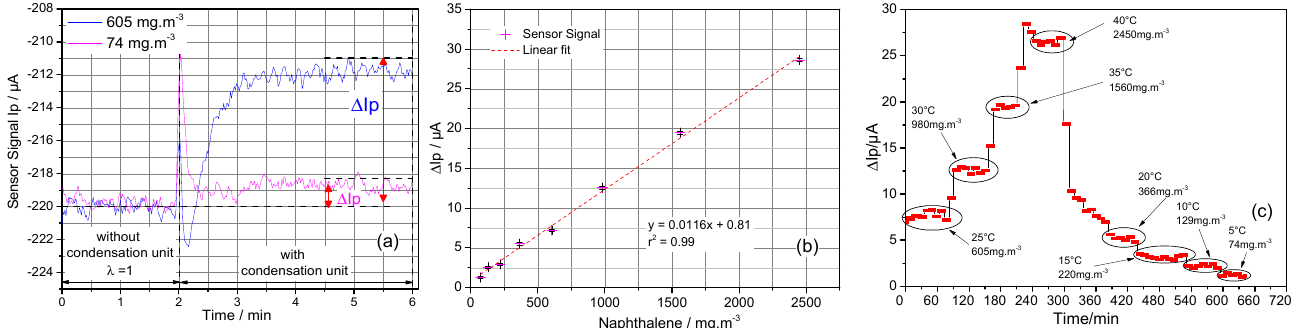
Figure 6. Determination of naphthalene in the N 2 /H 2 model gas mixtures at different concentrations. ( a ) Signal Ip vs. a time period of operation at two different naphthalene concentrations (605 mg/m 3 and 74 mg/m 3 ) at setting 1, λ = 1 (without the condensation unit) and at setting 2, λ > 1 (with the condensation unit). ( b ) Difference of the signal Δ Ip vs. different naphthalene concentrations. ( c ) Difference of the signal Δ Ip over time at different naphthalene concentration levels.